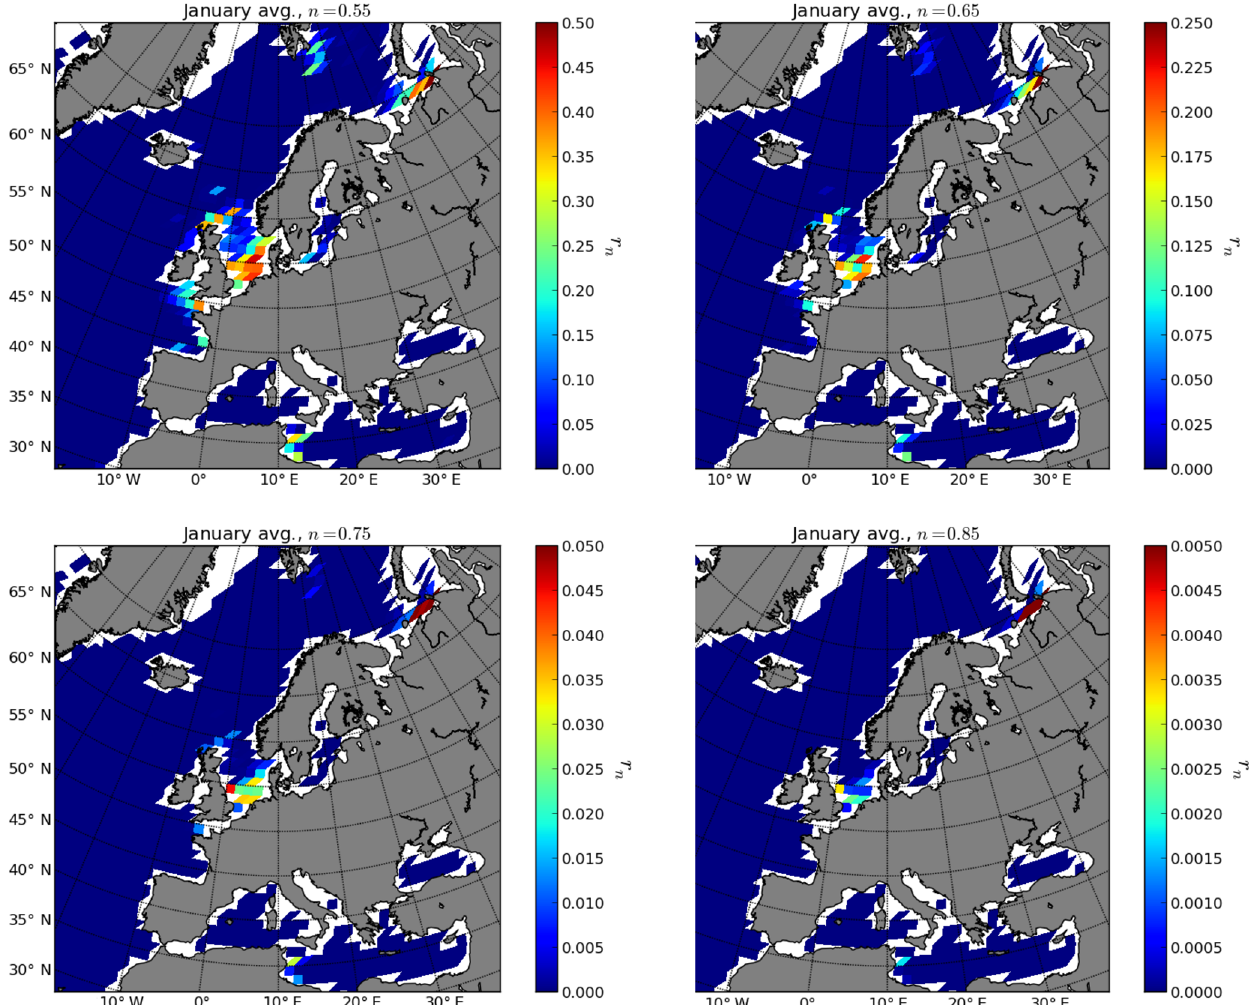
Figure 2. Average values of r 0 . 55 ,r 0 . 65 ,r 0 . 75 , and r 0 . 85 in January for the period